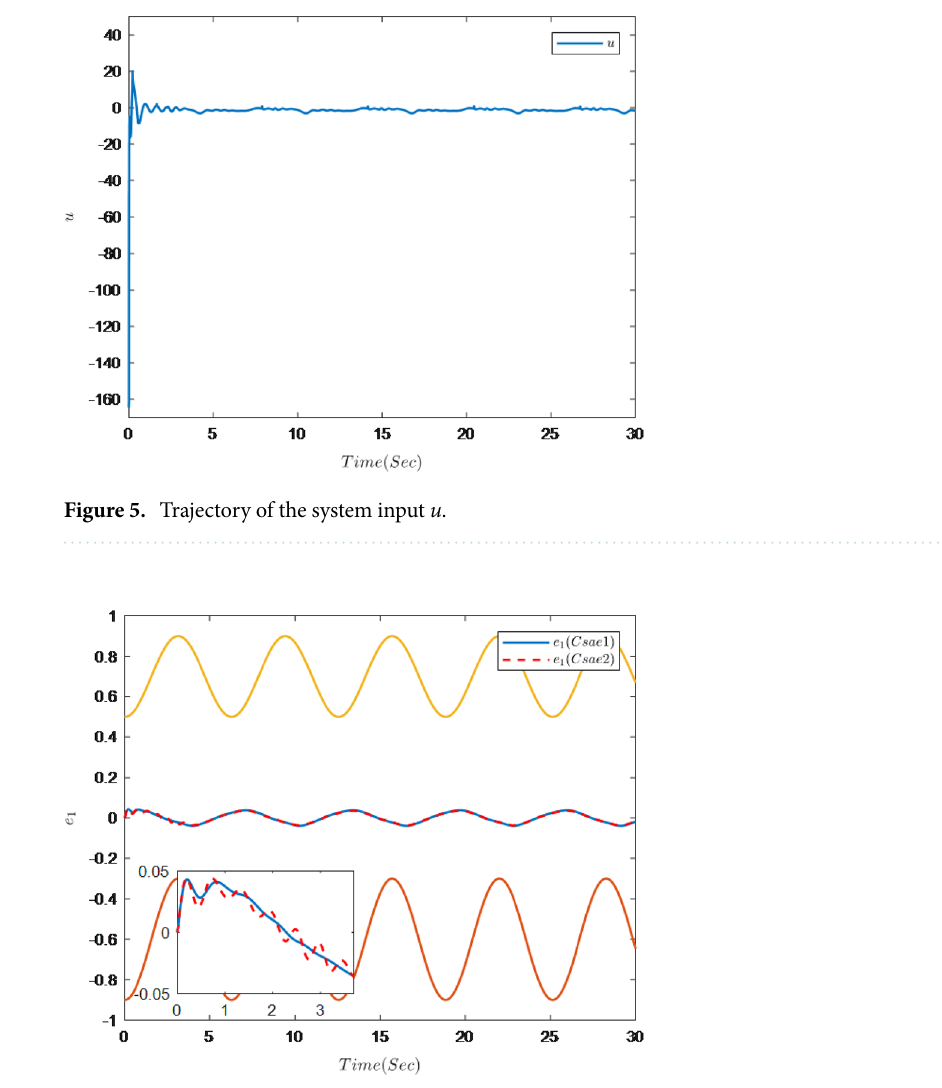
Figure 6. Trajectories of tracking error e 1 and constraint